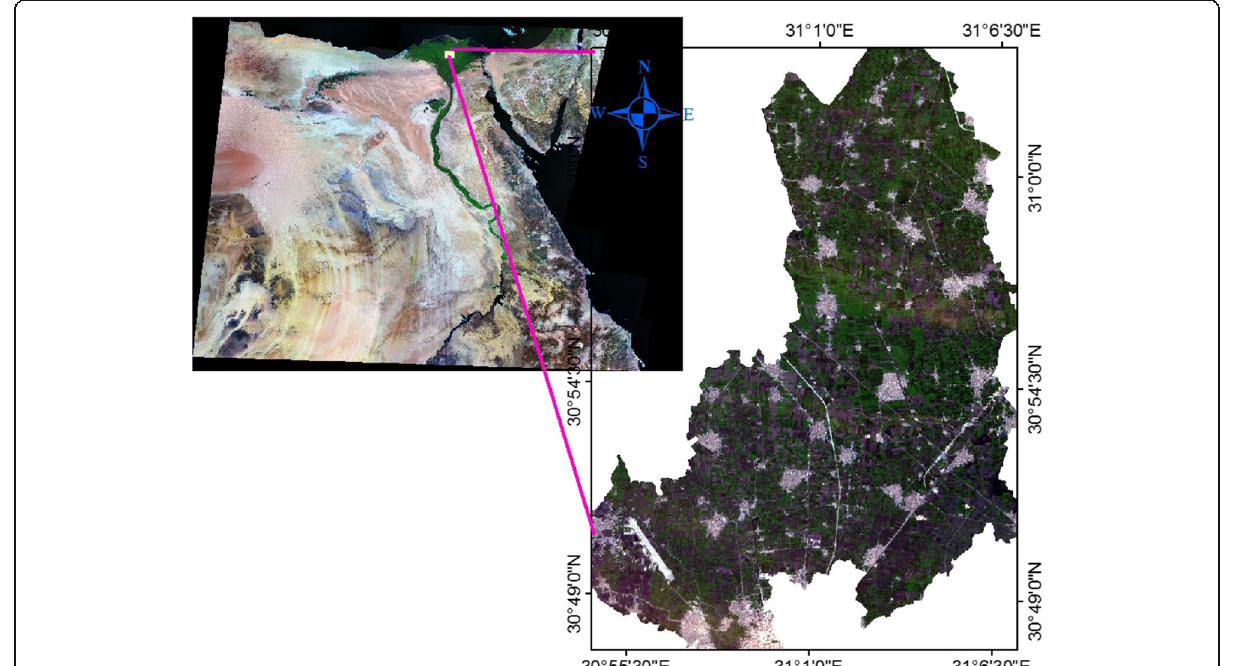
Fig. 1 Location of the study area at Tanta catchment area in the middle of the Nile